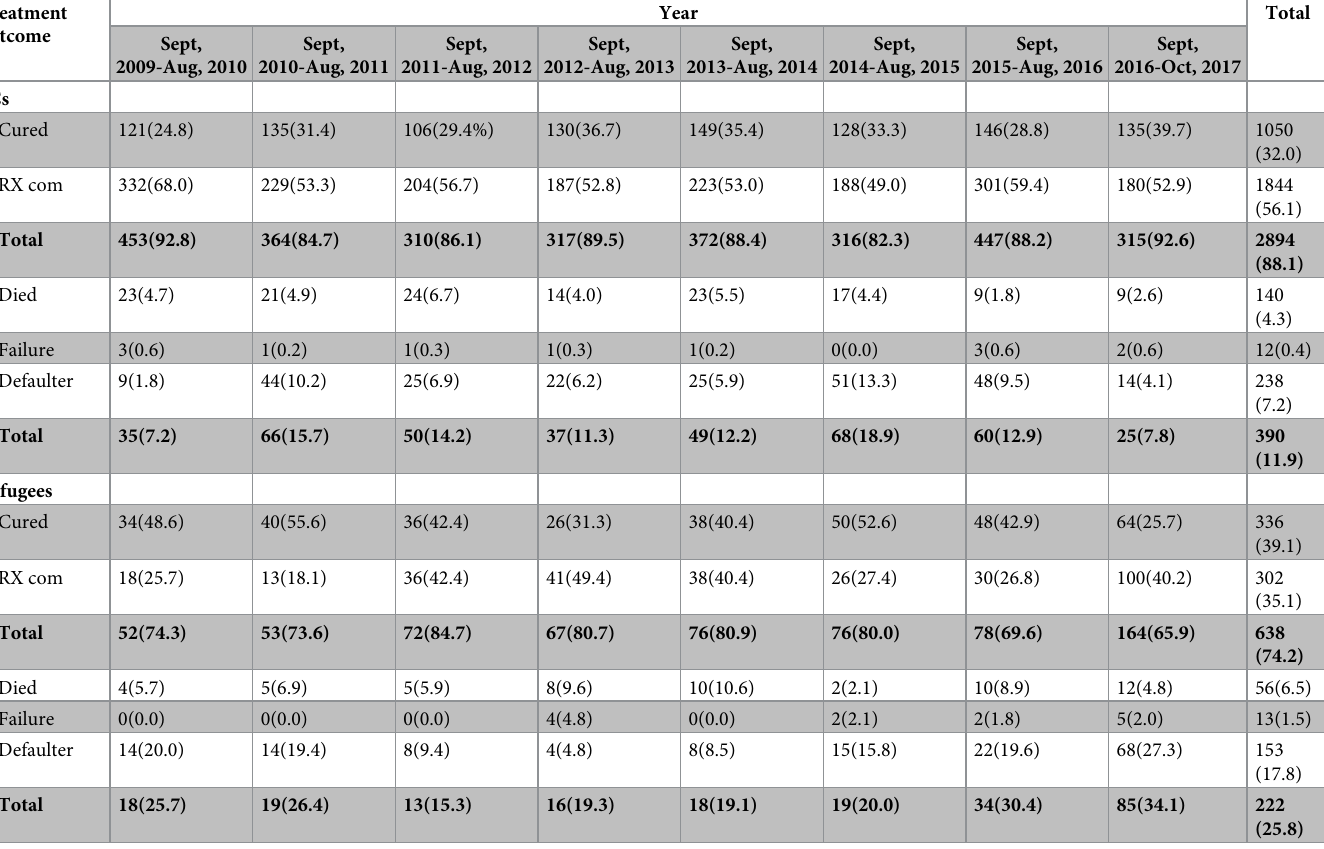
Table 2. Trends of TB treatment outcomes among refugees and surrounding communities registered TB cases in Gambella Regional State, South West Ethiopia, 2009–2017. Treatment